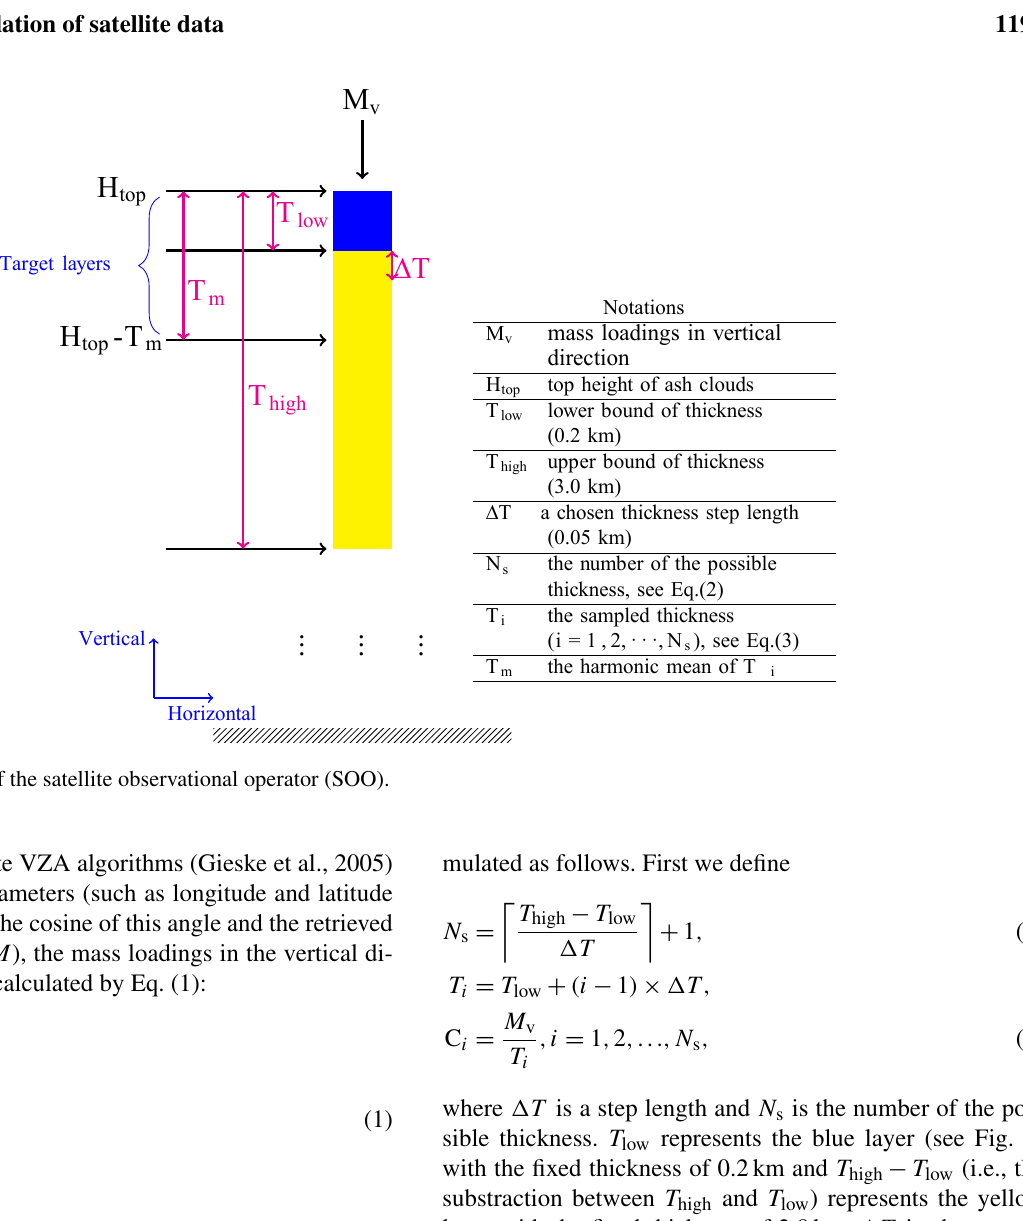
cording to the satellite VZA algorithms (Gieske et al., 2005) by using general parameters (such as longitude and latitude of each pixel). With the cosine of this angle and the retrieved ash mass loadings ( M ), the mass loadings in the vertical di- rection ( M v ) can be calculated by Eq.